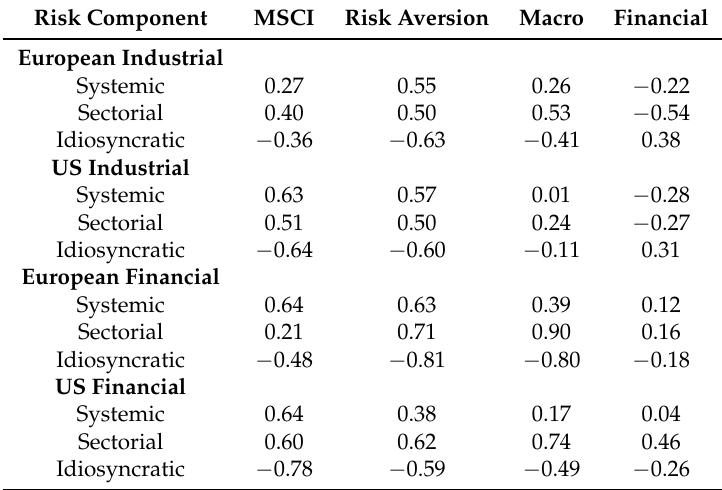
Table 19. Correlations between the size of the risk components and the sensitivity to the synthetic risk factors.